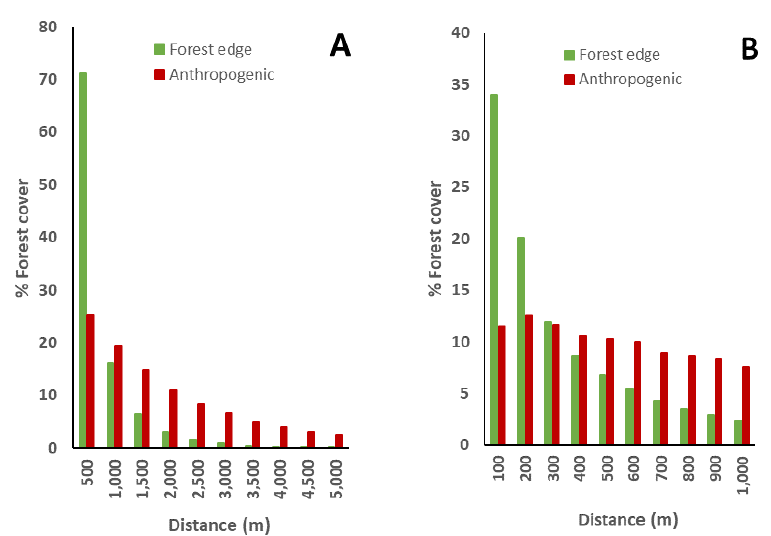
Figure 6. Proportion of forest cover impacted by fires, in relation to the distance from the forest edge and anthropogenic areas, in intervals of ( A ) 500 m for the first five kilometers and ( B ) 100 m for the first kilometer.